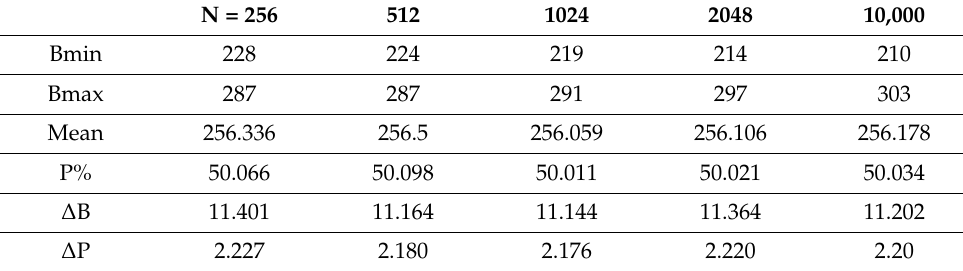
Table 9. Statically results for structure 1 for a number of different